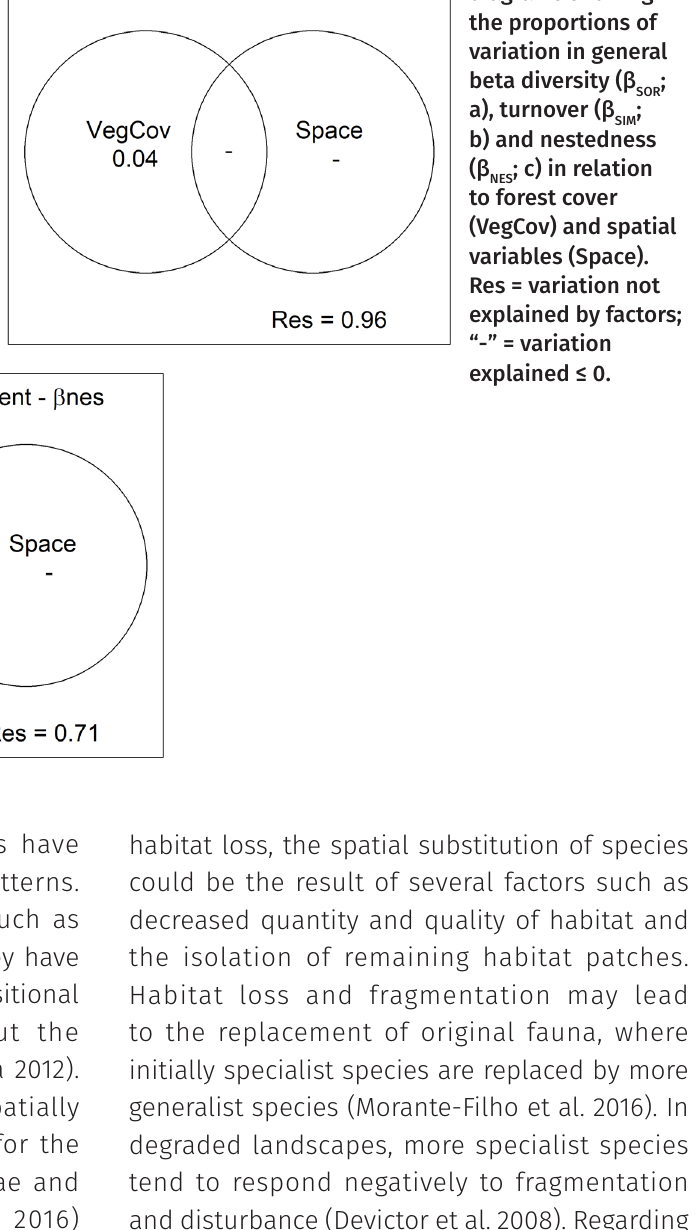
Figure 2. Venn diagrams showing the proportions